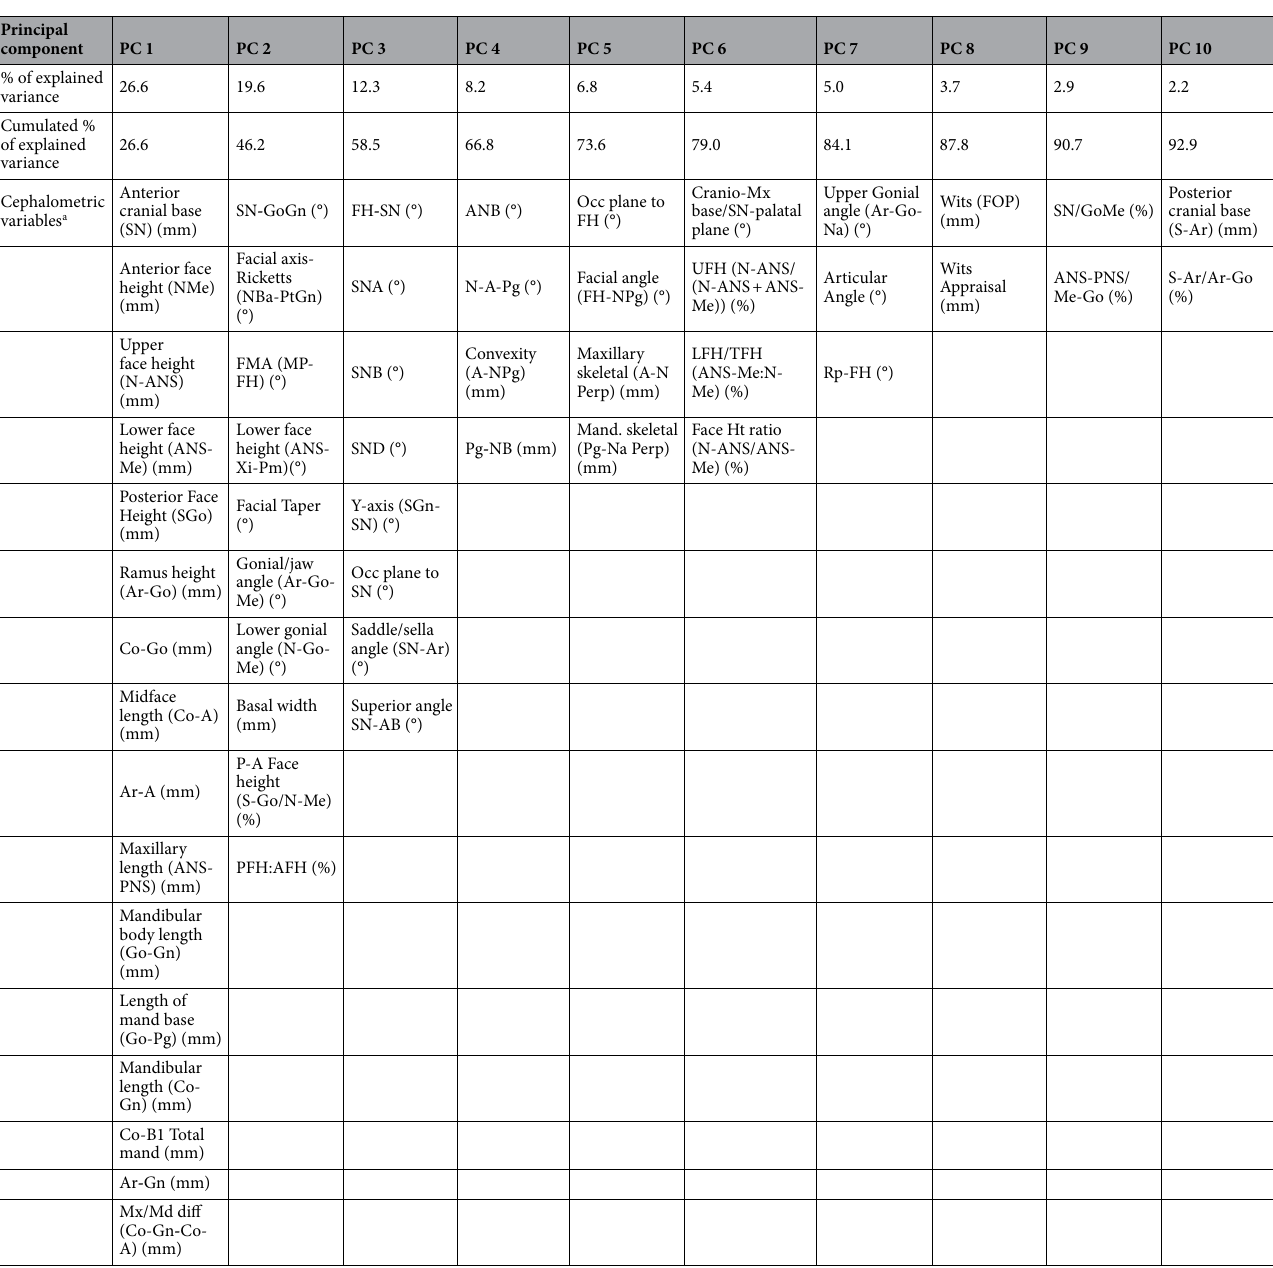
Table 2. Principal components generated based in a ten axes model. a variables with the highest contribution in each